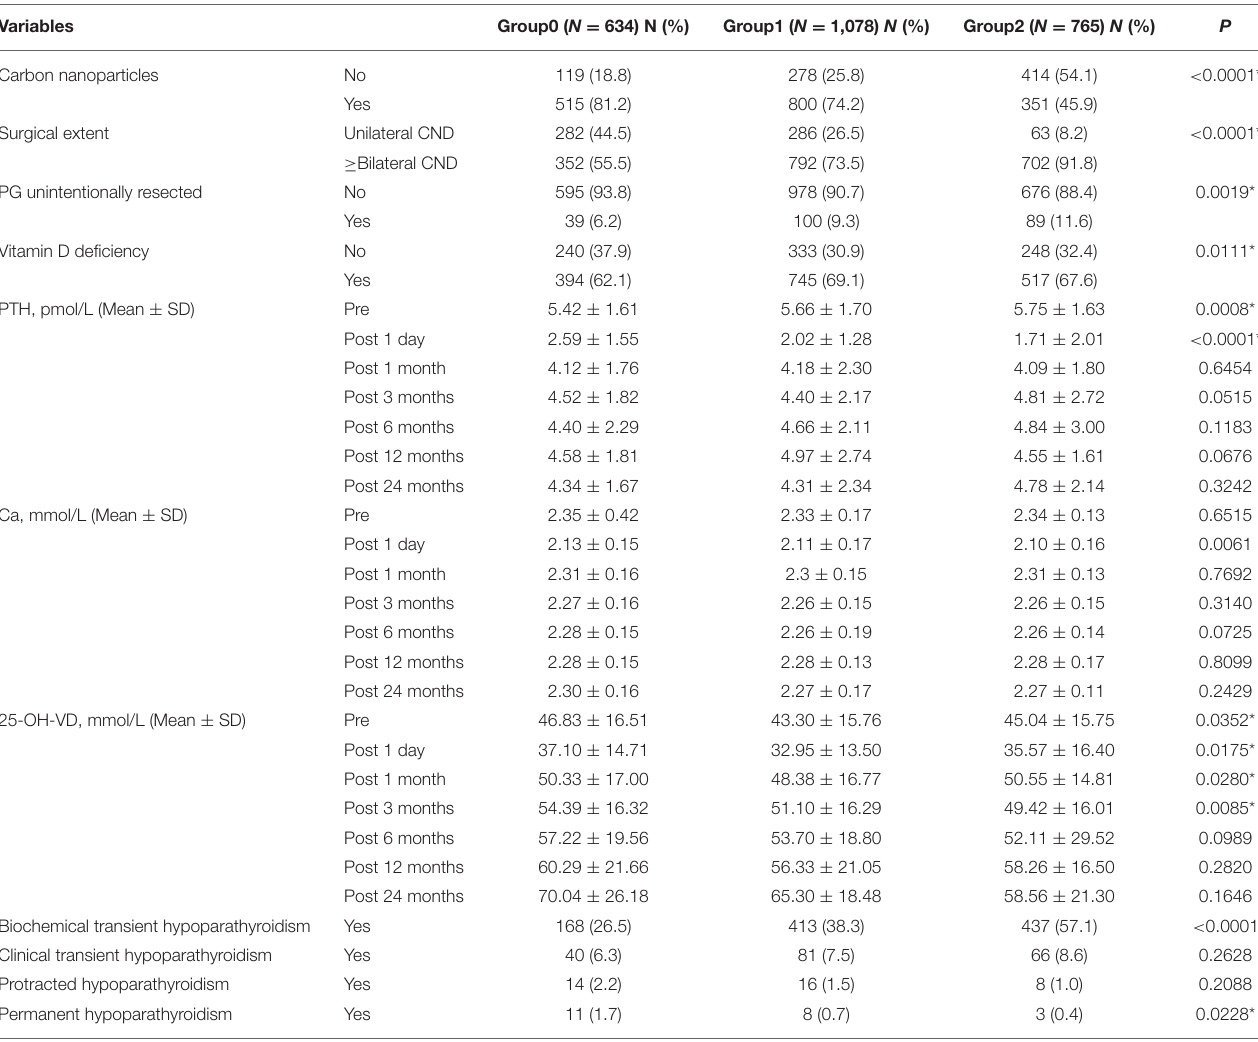
TABLE 2 | Parathyroid related characteristics of included